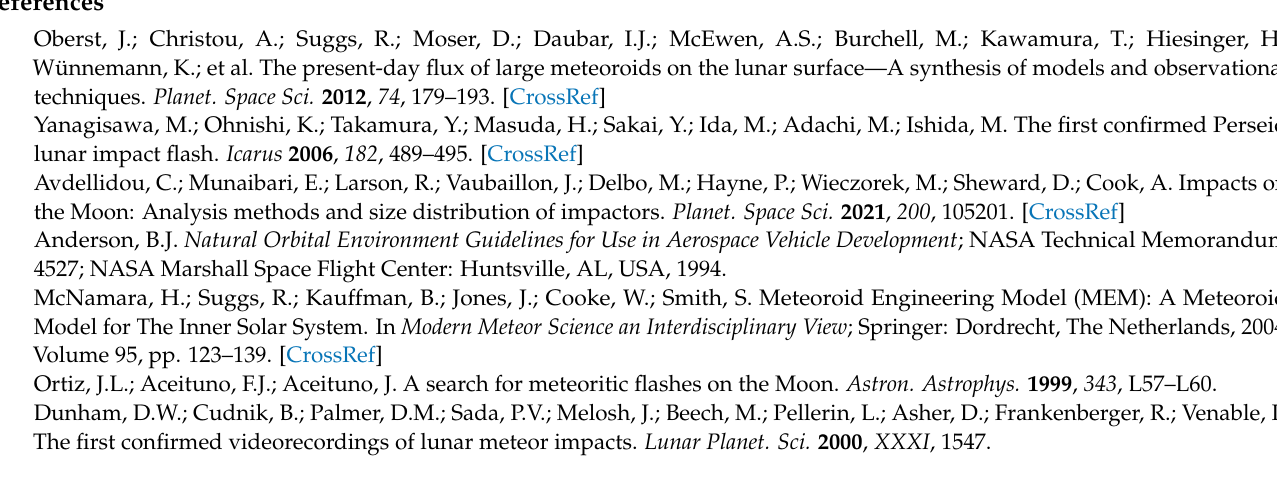
site, Figure S3: TIFF file generated by LunarScan for the frame with the peak of Flash 1, from the Macei ó recordings. Inverted colors, Figure S4: TIFF file generated by LunarScan for the frame with the peak of Flash 1, from the Araruna recordings. Inverted colors. The black spot is the flash. The white dots are hot pixels, Figure S5: TIFF file generated by LunarScan for the frame with the peak of Flash 2, from the Macei ó recordings. Inverted colors, Figure S6: TIFF file of seven-frame sequence generated by LunarScan for Flash 2, from the recordings at Macei ó , at 4.46 FPS, Figure S7: Reported ZHR of the Geminid meteor shower around its 2017 peak, according to the